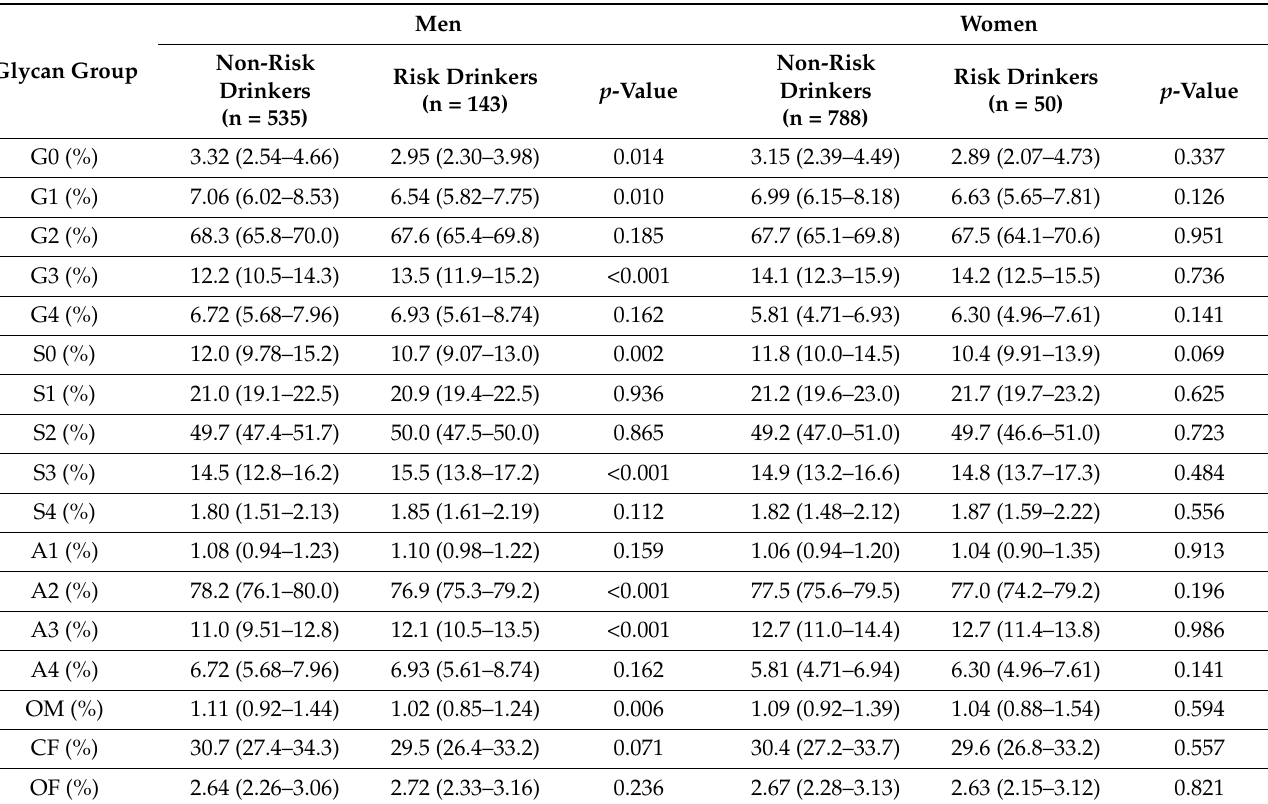
Table 4. Comparison of N -glycan peaks, aggregated in groups, between risk drinkers and non-risk drinkers, stratified by